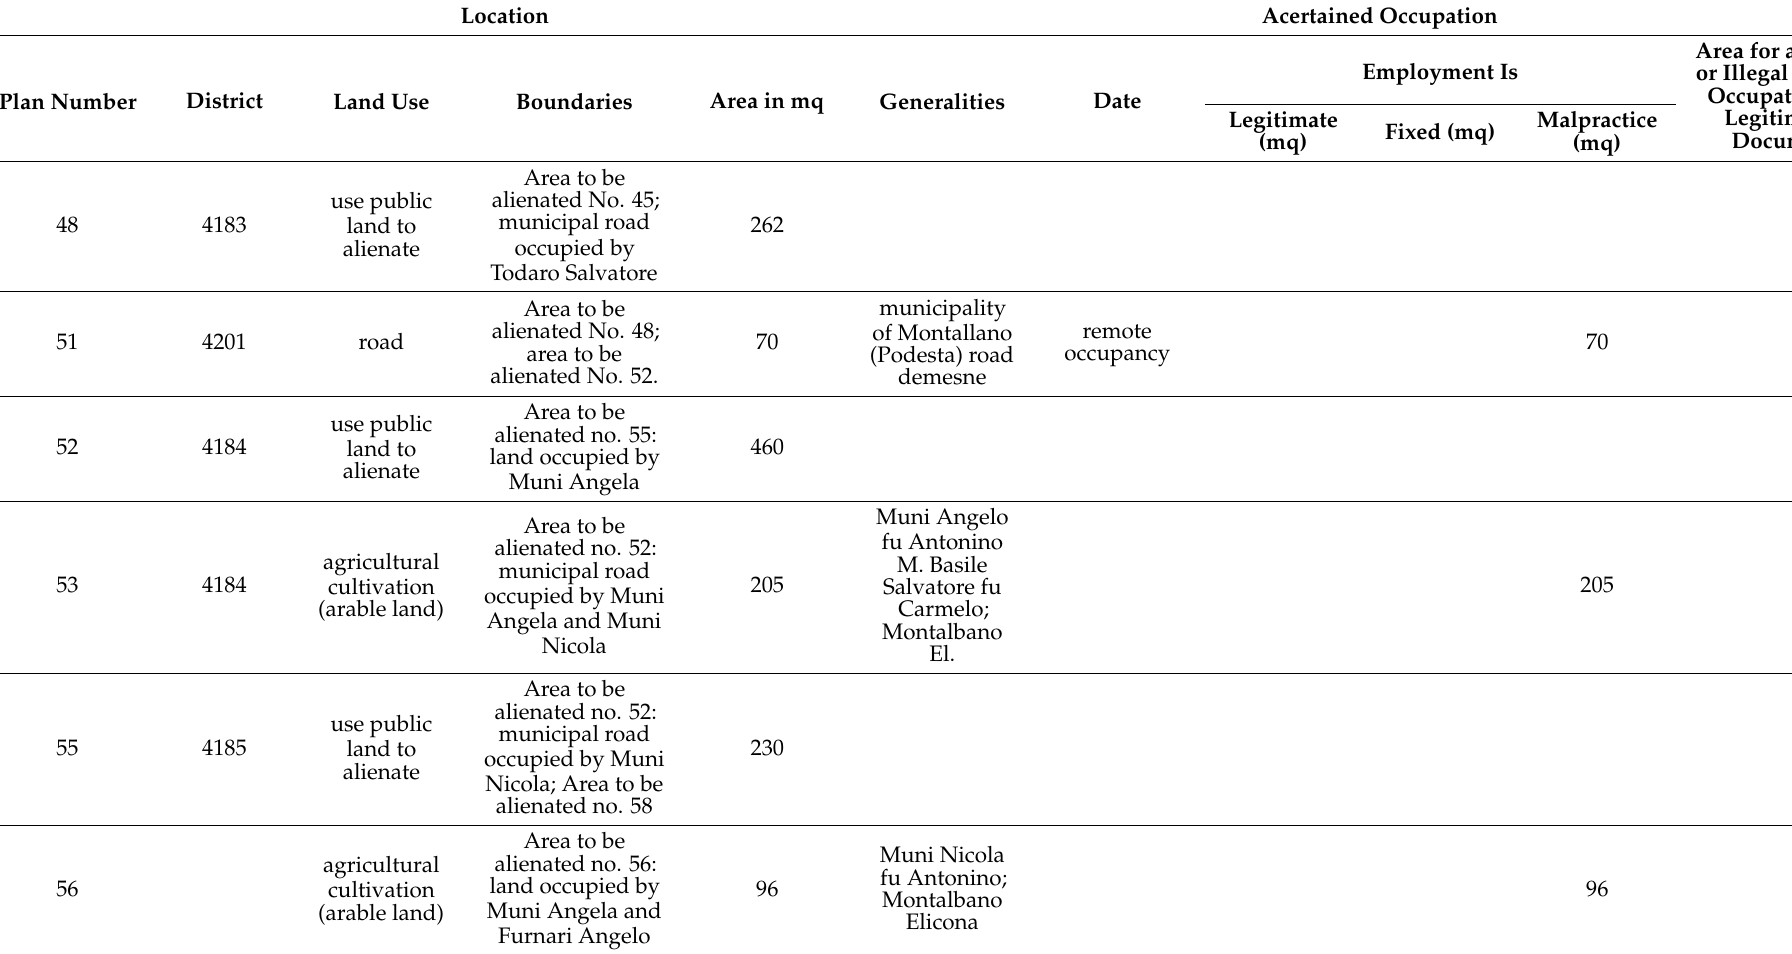
Table A1. Table of the body of register: ascertained occupation